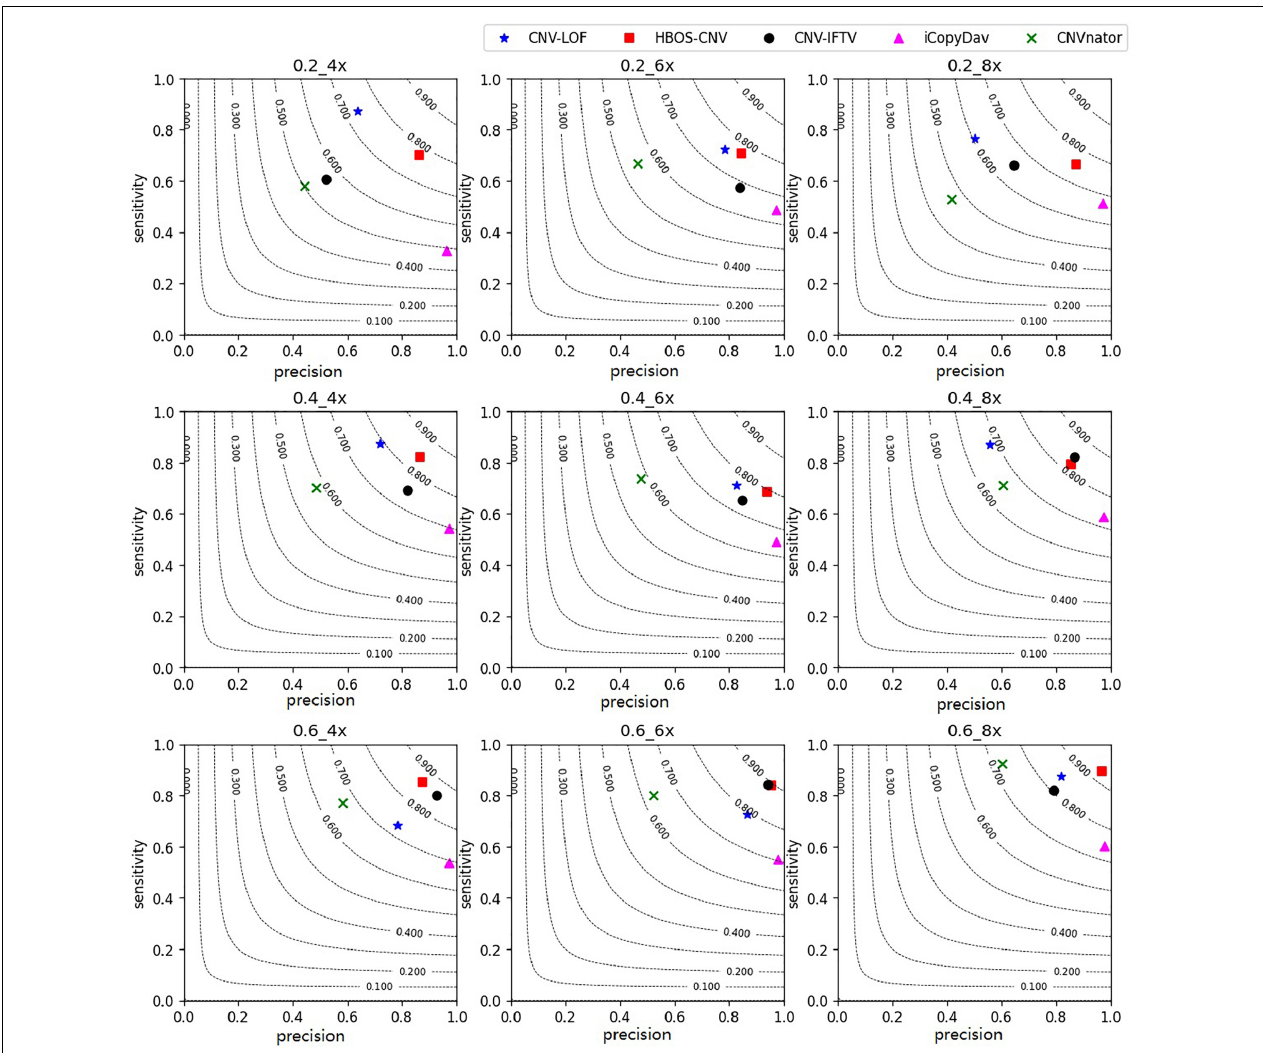
FIGURE 3 | Performance comparisons between the five methods with bin-size of 1000 in terms of sensitivity, precision, and F1-measure on simulation datasets. The F1-measure levels are shown in grey curves ranging from 0.1 to 0.9.